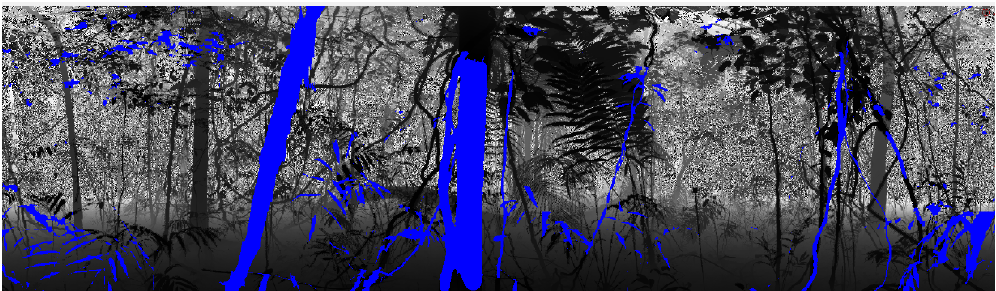
Figure 9. TLS data before liana removal with azimuth ranging from 0 ◦ to 360 ◦ and zenith ranging from 30 ◦ to 130 ◦ . The data is colored according to range of the laser pulse with black being low and white being high. The areas with blue indicates regions of no returns either because the object was too close to the scanner (<1.5 m) or because of a